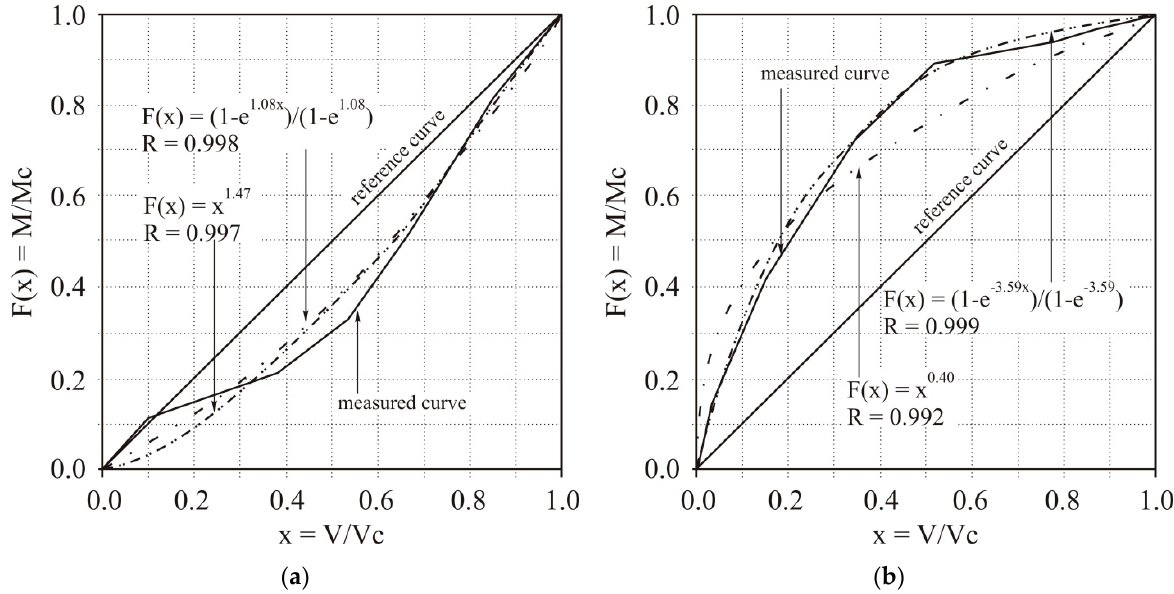
Figure 4. The pattern of variation M/M c = f ( V/V c ) for Ni measured and extrapolated by Equations (3) and (4): ( a ) high water stage 6; ( b ) high water stage 11.